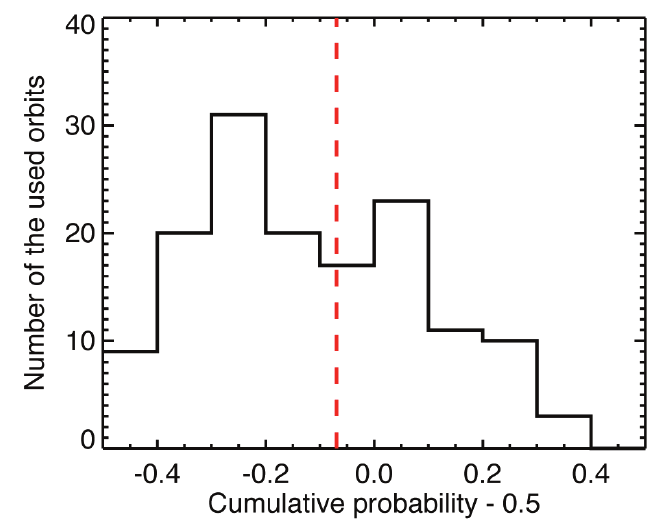
Figure 5. Distribution of the mean values of the CDFs that contribute to the observed wave intensity decrease. Vertical dashed red line, mean